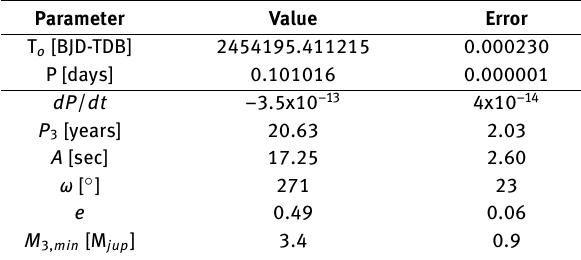
Table 2. Results from the O-C